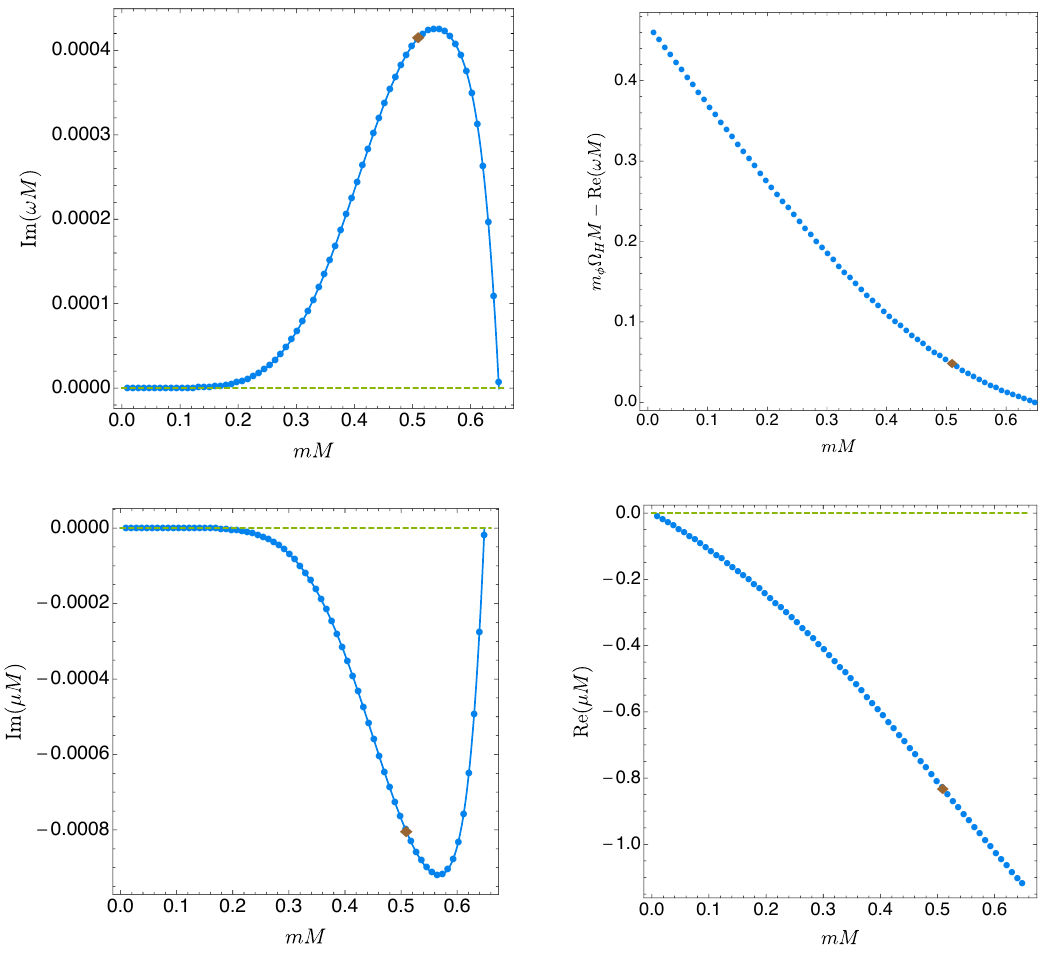
Figure 1 . Kerr black hole: e(cid:11)ect of Proca mass. Unstable Proca modes for a Kerr black hole with J=M 2 = a=M = 0 : 998 ( m (cid:30) = 1) as a function of the dimensionless Proca mass mM . The upper panels describe the imaginary (left) and real part (right) of the dimensionless frequency !M , while the lower panels give the imaginary (left) and real (right) parts of the dimensionless angular eigenvalue (cid:22)M . For this J=M 2 the instability is present for 0 < mM . 0 : 64853159519, and the maximum of Im( !M ) occurs for mM (cid:24) 0 : 5391620000. The brown diamond signals the solution with Proca mass mM = 0 : 51 that will be analyzed in the Kerr-Newman and Kerr-Sen backgrounds (see (cid:12)gure